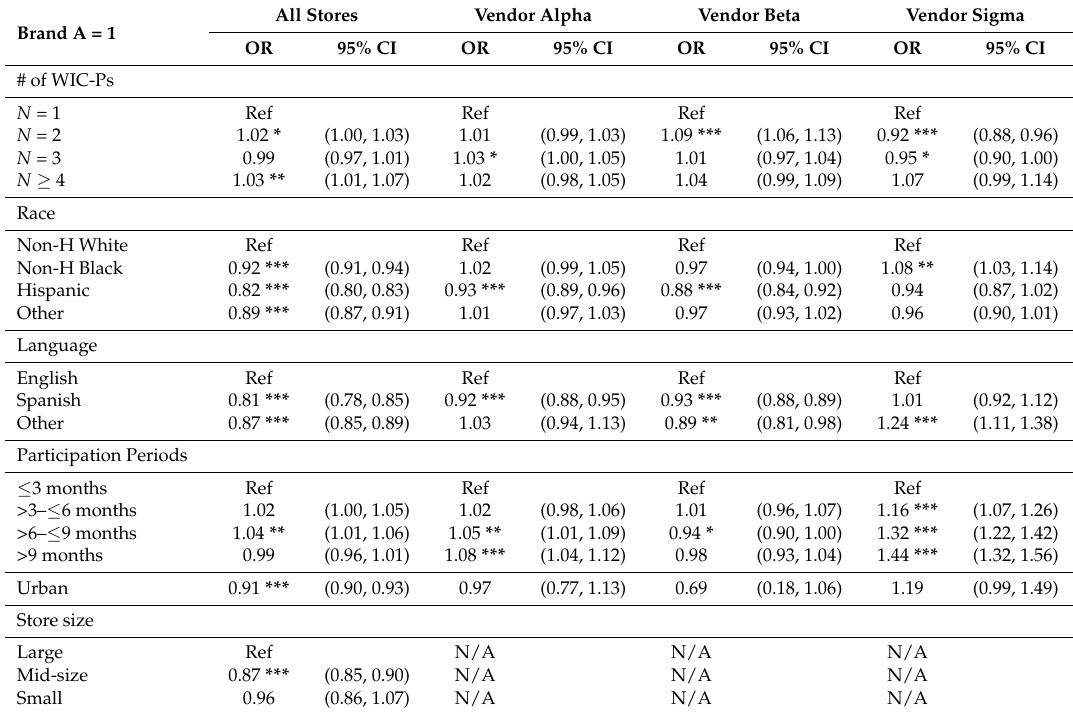
Table 4. Mixed effects logistic regression results of the selection of Brand A bread among WIC participants in